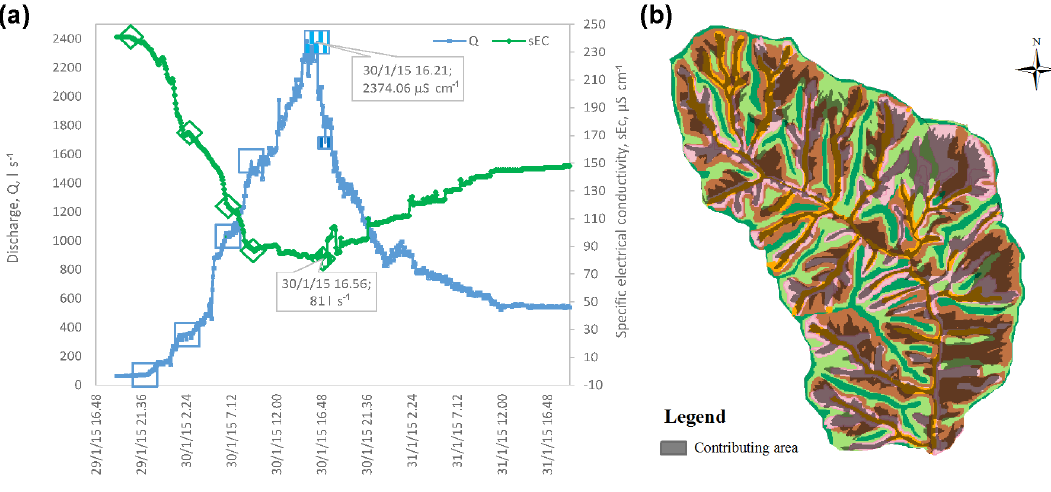
Figure 13. Final hydro-chemograph conditions, after approximately 100mm of rainfall inducing a peak discharge of approximately Q = 2400Ls − 1 , filled blue square, and about EC = 80µS − 1 , filled green diamond, (b) corresponding both to full saturation excess contri- butions to streamflow from the riparian corridor and colluvial hollows, as well as to macropore (soil pipe and fracture) and excess infiltration on noses and partially on the ridges,